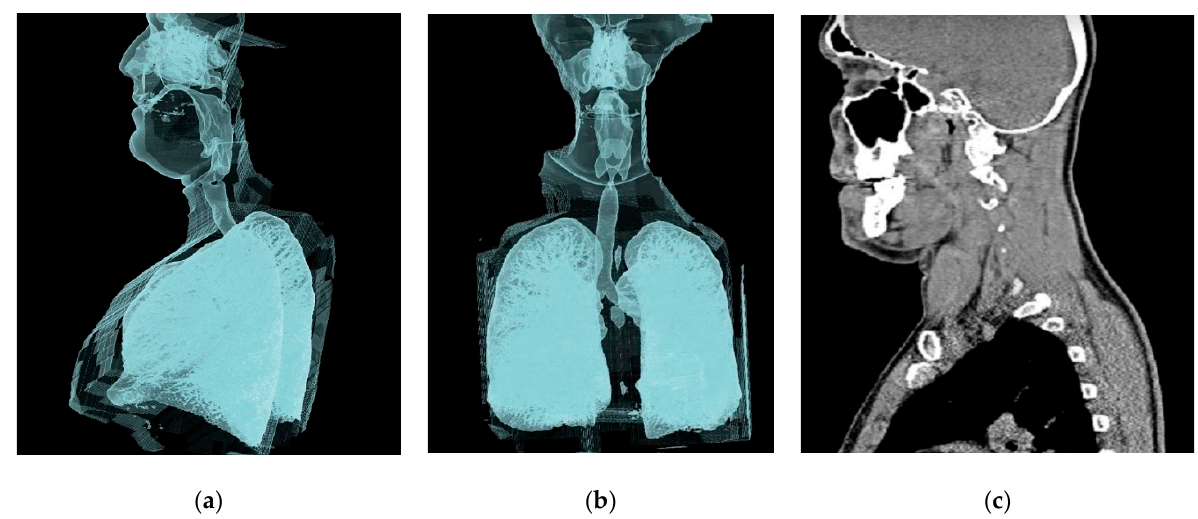
Figure 1. Different views of the computed tomography (CT) images used in this study: ( a ) 3D render, sagittal view; ( b ) 3D render, coronal view; ( c ) CT image scan, sagittal view.